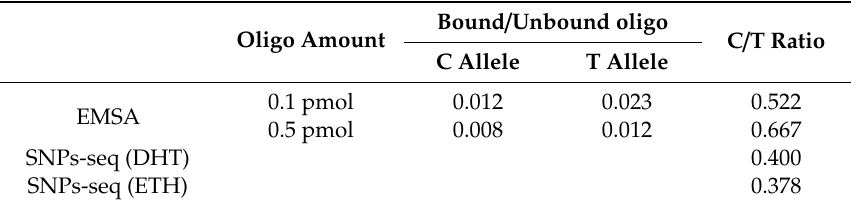
Figure 5. Validation of SNP rs12246440 by EMSA. Compared to T allele, C allele shows weaker protein binding in both 0.1 pmol and 0.5 pmol oligo. The binding signal is reduced by the addition of unlabeled oligos. The ratio of C to T allele from EMSA is consistent with ratio from SNPs-seq. Table 2. Comparison of EMSA with SNPs-seq for